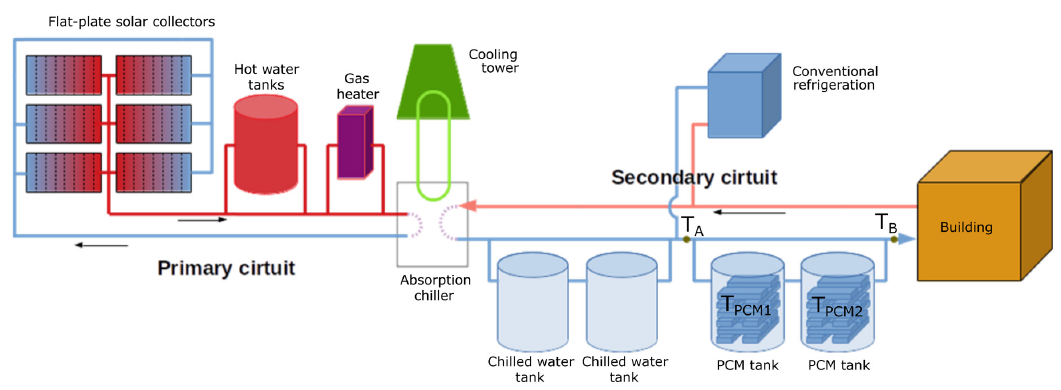
Figure 15. Schematic representation of the upgraded SCH system coupled with two newly designed PCM storage systems in CIESOL, with the places of measuring the temperature for the added tanks highlighted.